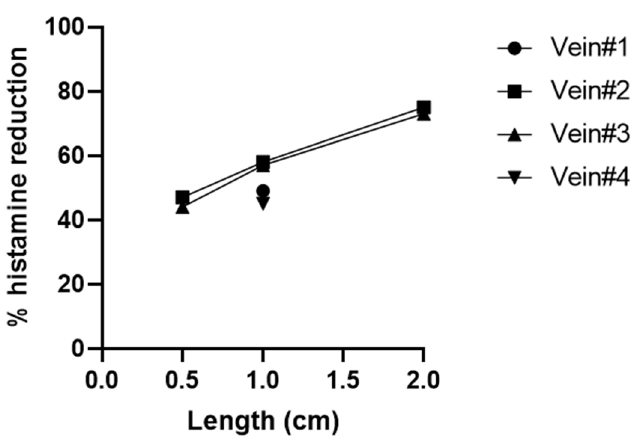
Figure A1. Histamine removal of unstimulated vein. Varicose saphenous vein of 0.5 cm ( n = 2), 1 cm ( n = 4) or 2 cm ( n = 2) pieces were incubated 1 h with 200 ng/mL histamine in supernatant. % histamine reduction was calculated by comparing measured histamine after incubation with histamine levels of control supernatant (tube ran in parallel without added vein piece). #: Number of vein tested.